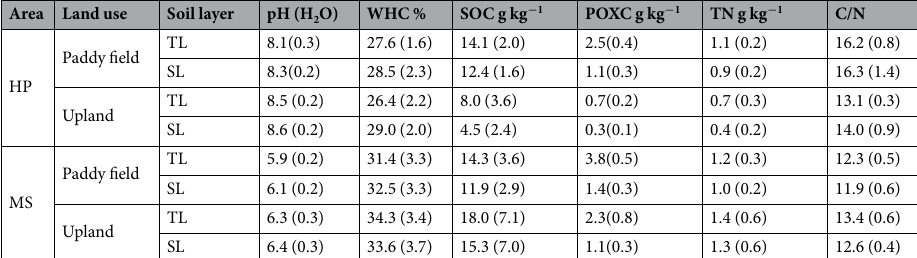
Table 1. Soil physicochemical properties of the topsoil layer (TL) and subsoil layer (SL). Values are means of six sampling sites in each area (Huaping, HP and Meishan, MS). Numbers in parentheses are standard deviations (n =